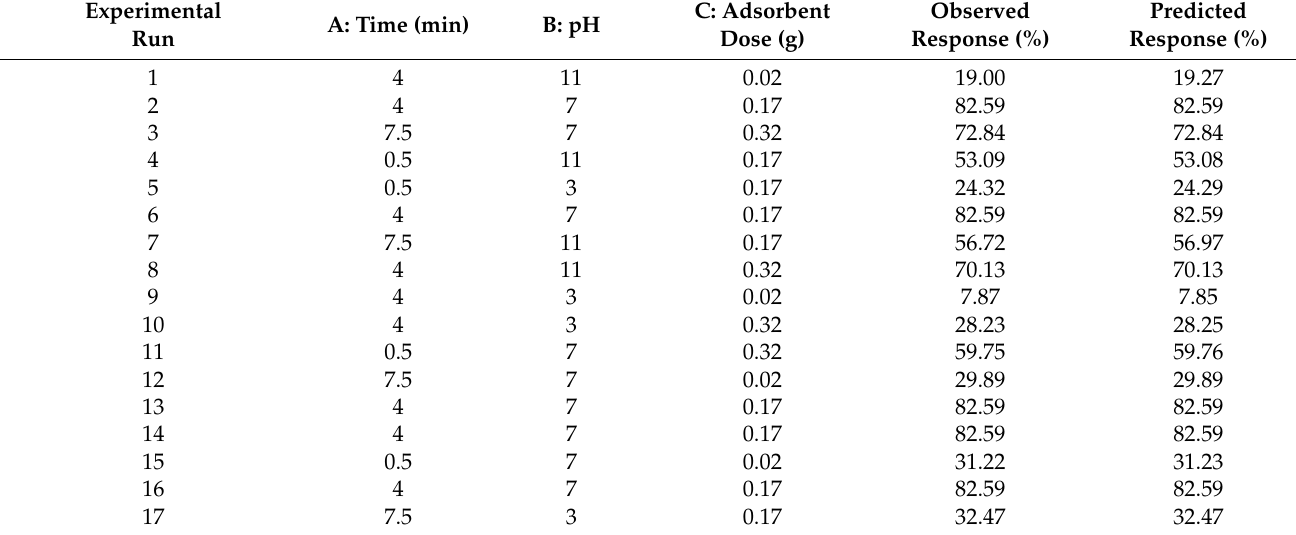
Table 1. Box–Behnken design matrix data: experimental and predicted values.